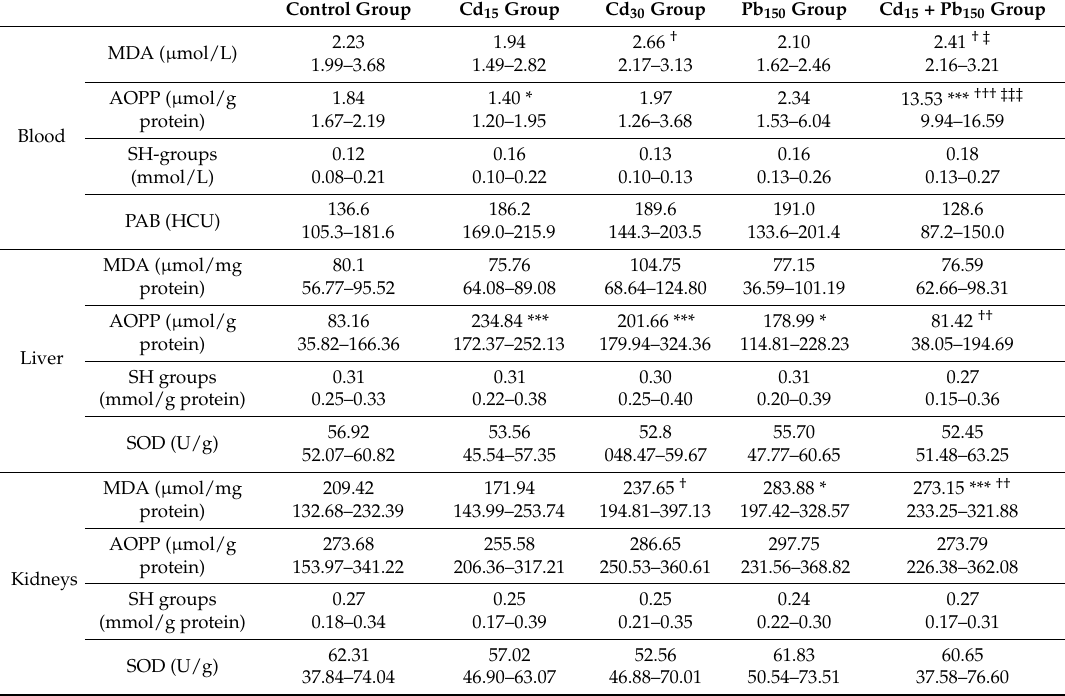
Table 3. Redox parameters in rat blood, liver, and kidney after Cd or/and Pb acute